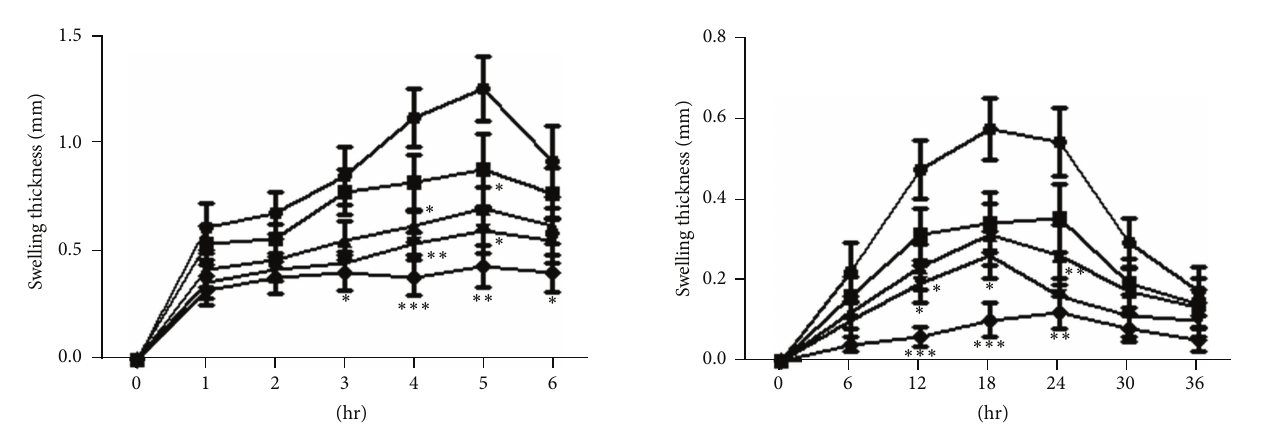
Figure 4: Inhibitory effect of patuletin on histamine-induced hind- paw edema in mice. Drugs were administered p . o . 30min before his- tamine(5 𝜇 g). e :control; ◼ :patuletin5 mg/kg; 󳵳 :patuletin15 mg/kg; 󳶃 : patuletin 50 mg/kg; Q : cyproheptadine 10mg/kg. Significantly different from the control, ∗ 𝑃 < 0.05 , ∗∗ 𝑃 < 0.01 , or ∗∗∗ 𝑃 < 0.001 . Each value represents the mean ± SD of 5 mice.